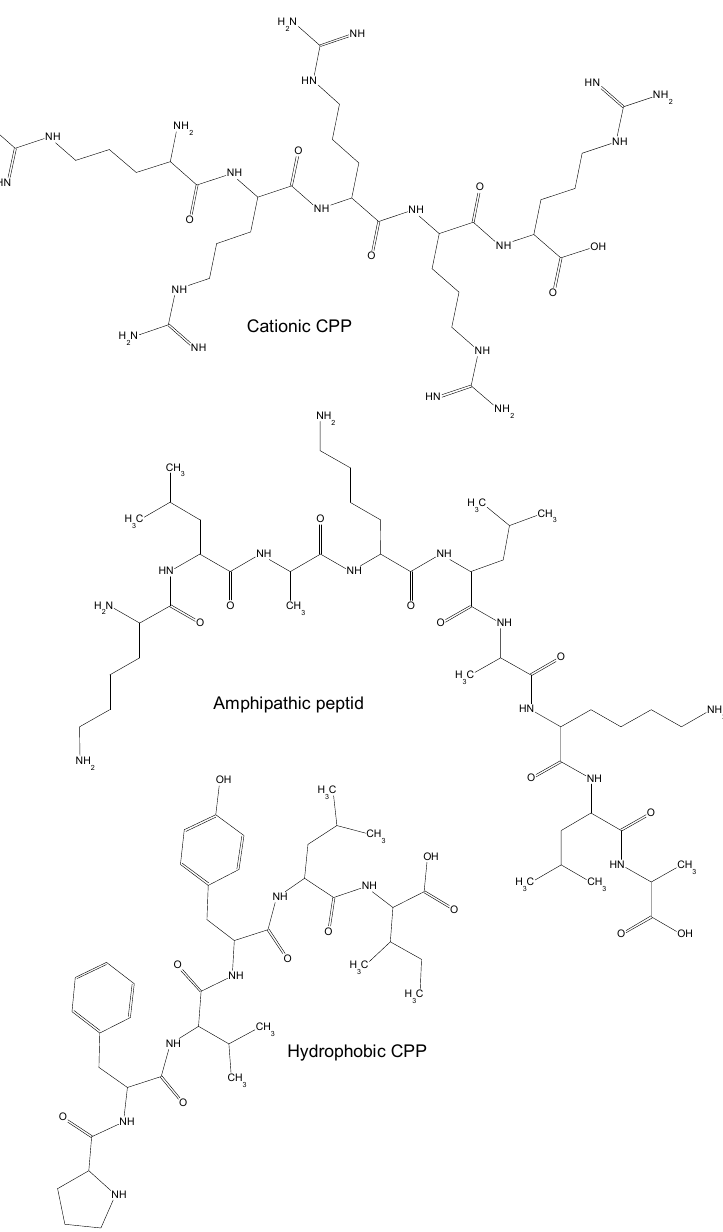
Figure 1. Representative structures of the three classes of CPPs: polyarginine (as cationic prototype, RRRRR), amphipathic (i.e., KLAKLAKLA) and hydrophobic (i.e., PFVYLI). Several chimeric amphipathic CPPs have been obtained by a covalent bound of a hydrophobic sequence of the two chimeric peptides MPG (GLAFLGFLGAAGSTMGAWSQPKKKRKV) and Pep1 (KETWWETWWTEWSQPKKRKV) is based on the SV40 NLS (PKKRKV) linked to the HIV